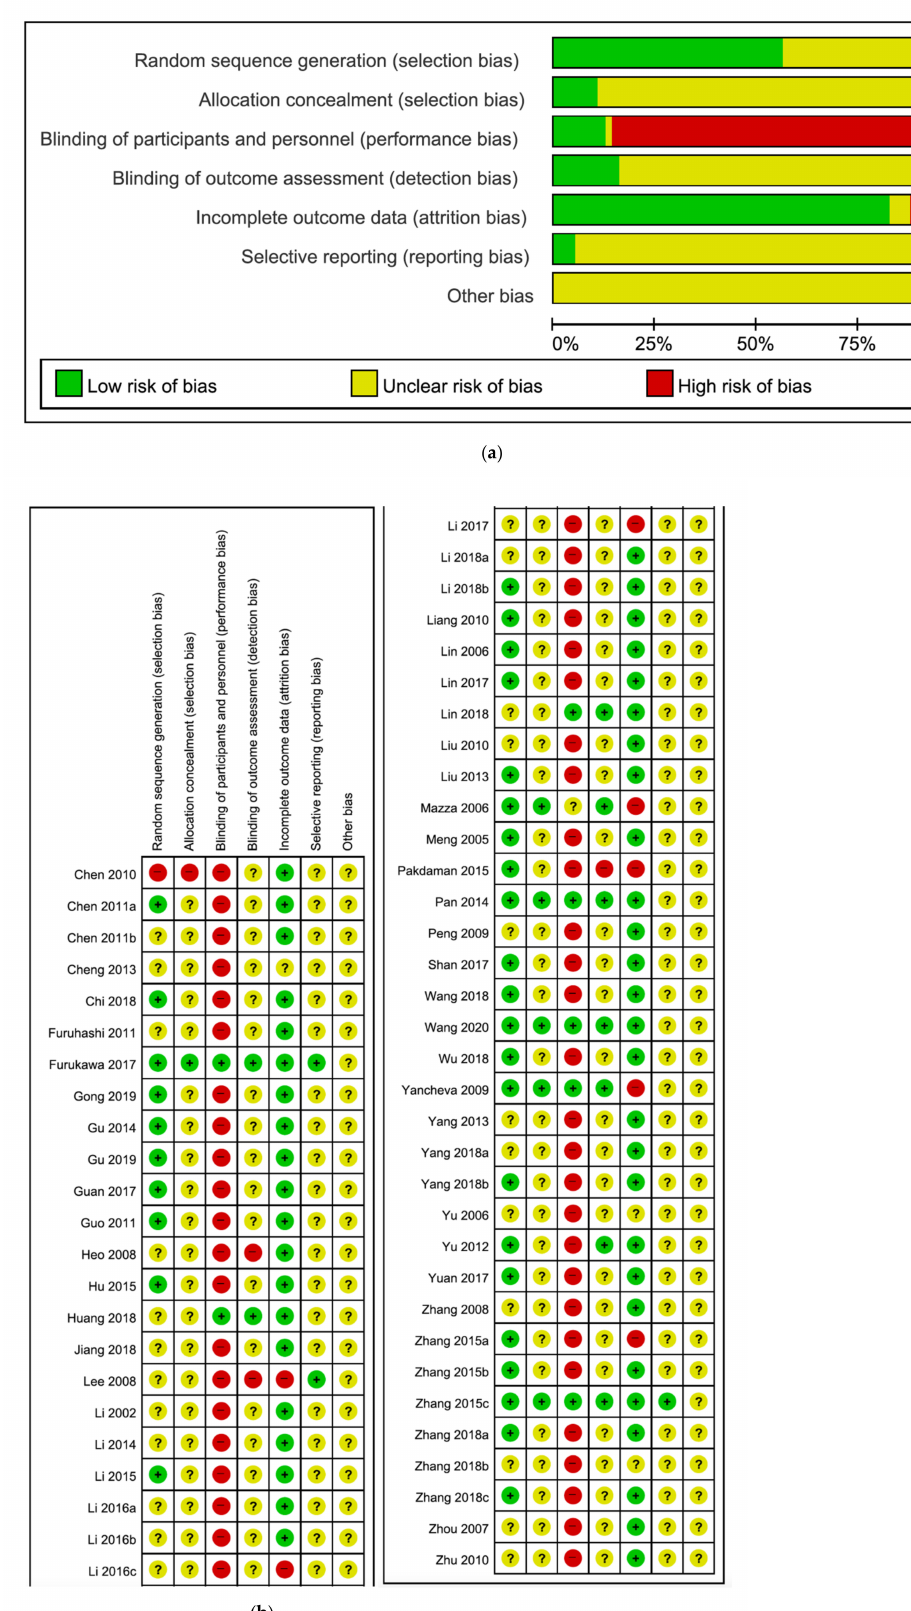
Figure 2. ( a ) Risk of bias graph. ( b ) Risk of bias summary (“+” = low risk of bias, “ − ” = high risk of bias, “?” = unclear risk of